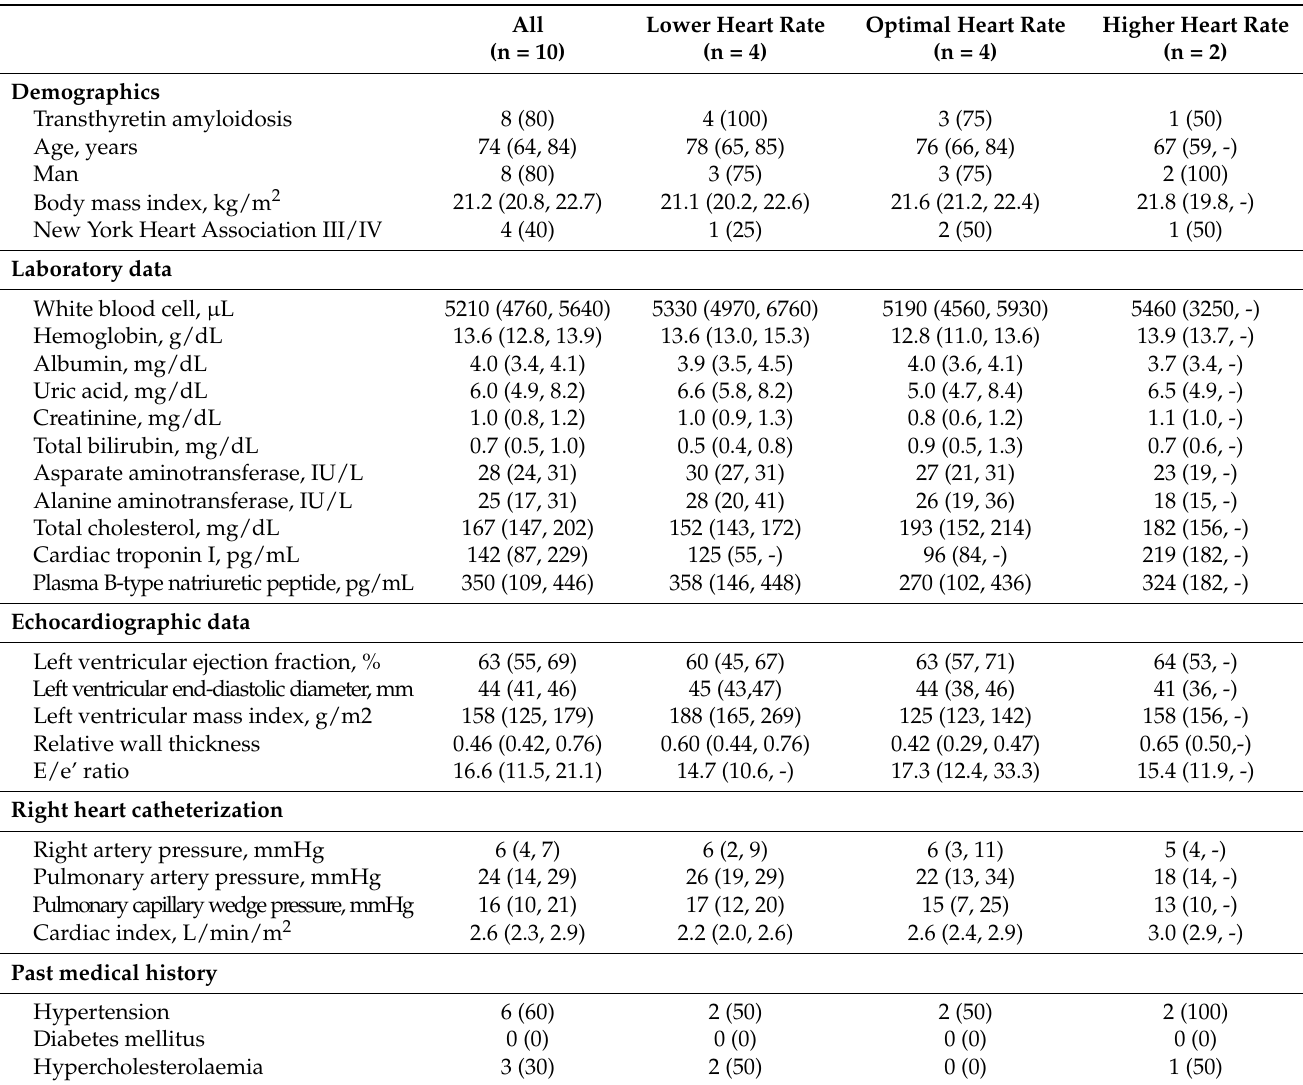
Table 1. Baseline